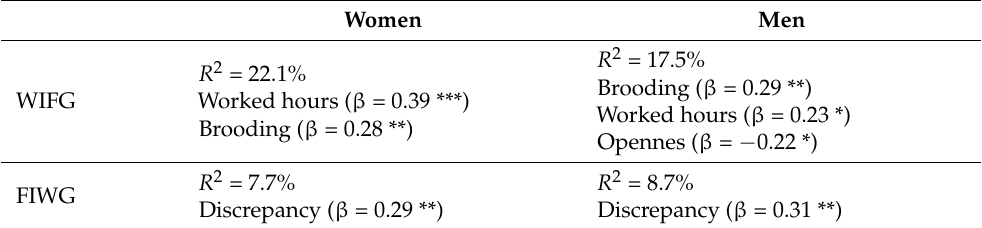
Figure 2. Johnson–Neyman plot of the moderating effect of gender on the relationship between satisfaction with life (SWLS) and work interference with family guilt (WIFG). Table 4. Regression models to predict WIFG and